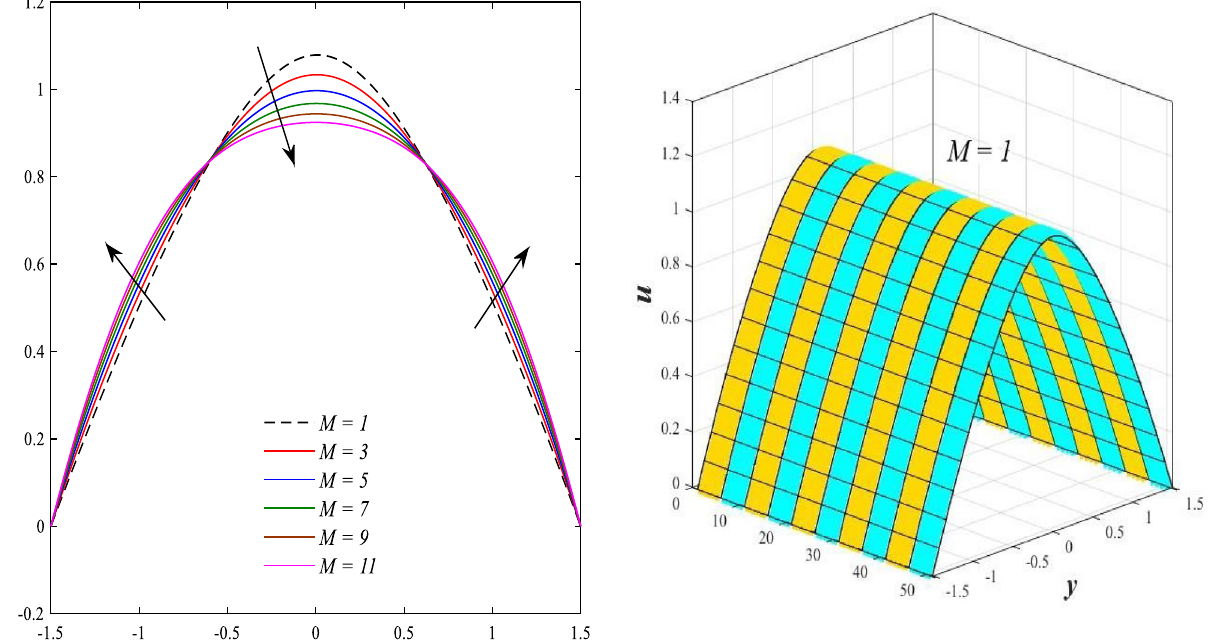
Figure 4. Effect of magnetic field parameter M on the axial velocity distribution 2D and